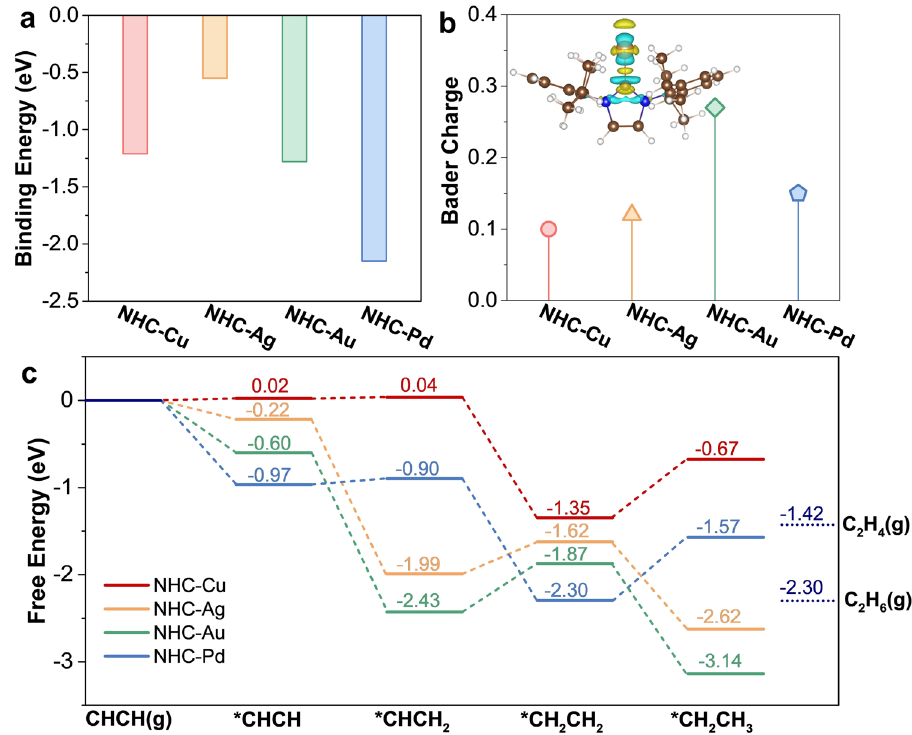
Fig. 1 Theoretical calculations of NHC – metal complexes. a Calculated binding energies ( E b , eV) between the NHC ligands and metal atoms in NHC – metal complexes. b Bader charge transfer from the NHC ligands to the metal sites. The inset displays the regions of charge accumulation (yellow) and depletion (cyan) in NHC – Cu. c Calculated free energy diagram of acetylene hydrogenation on NHC – metal complexes at a potential of 0 V vs.